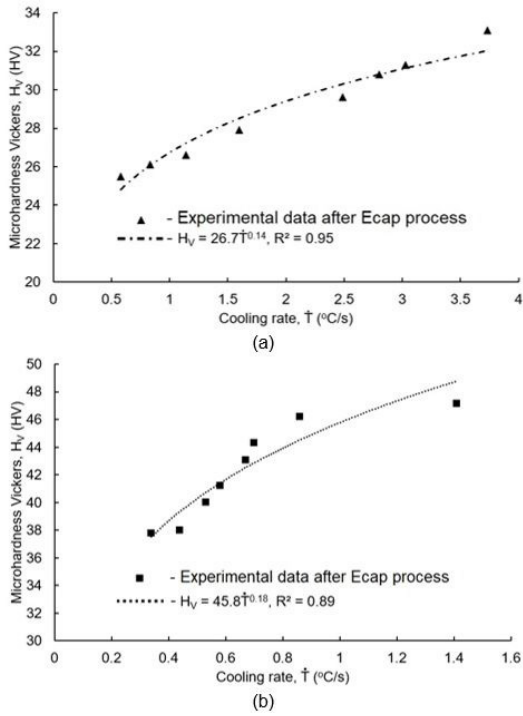
) after ECAP versus V